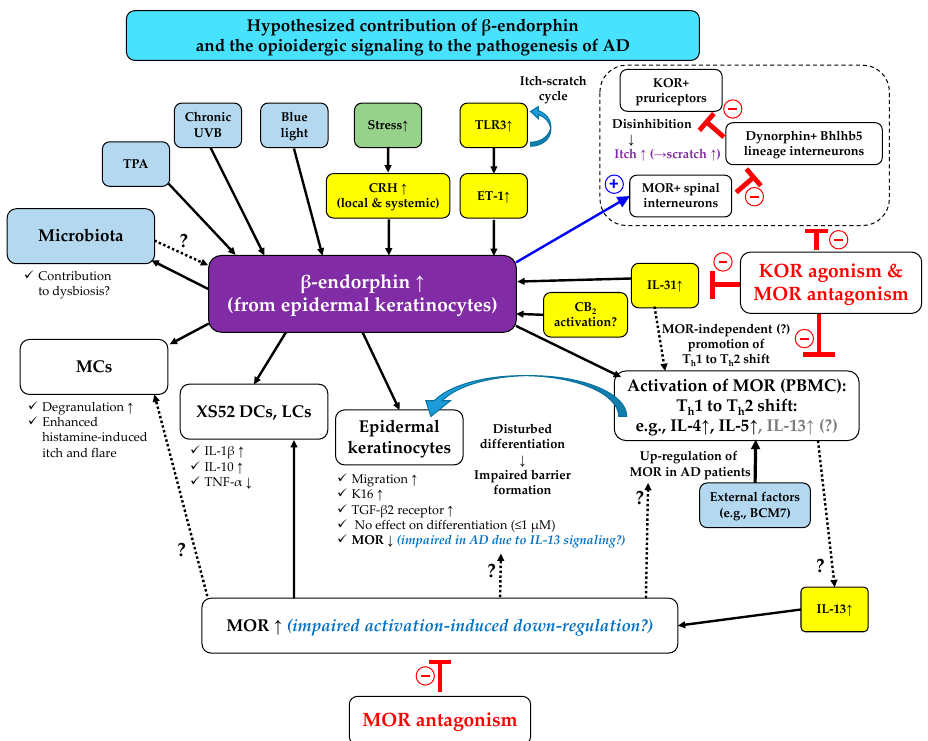
Figure 5. Hypothesized contribution of β -endorphin and IL-13-induced upregulation (or impaired activation-induced downregulation) of MOR to the pathogenesis of AD. Blue background marks external factors, internal contributors are highlighted with yellow background, whereas green background indicates that stress can be the consequence of internal and external causes as well. As shown on the figure, β -endorphin appears to be a common point in multiple AD-relevant pathways. Although there is a continuous β -endorphin-mediated activation, at least in a subset of the AD patients, MOR does not downregulate, most likely because of the presence of IL-13 and/or certain external factors (e.g., BCM7). This may lead to pathologically prolonged MOR activity further skewing the immune response toward T h 2 polarization, and possibly disturbing differentiation of epidermal keratinocytes, as well as maturation/degranulation of cutaneous MCs. However, it should also be noted that certain data argue for a different working hypothesis. Indeed, as mentioned in the main text, certain reports argue that expression pattern of MOR alters in certain AD patients, i.e., MOR becomes intracellular in the keratinocytes of the lesional skin, which leaves MOR on the sensory neurons without competition for the ligand ( β -endorphin), leading to overactivation of the said neuronal receptors [193,240,247]. (Question marks indicate hypothesized effects.)